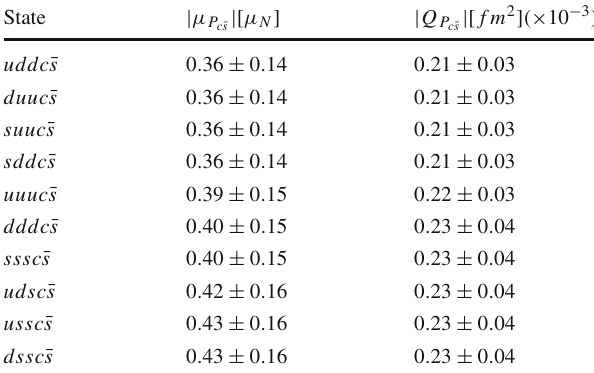
Table 1 Numerical values of the magnetic dipole and electric quadrupole moments of P c ¯ s